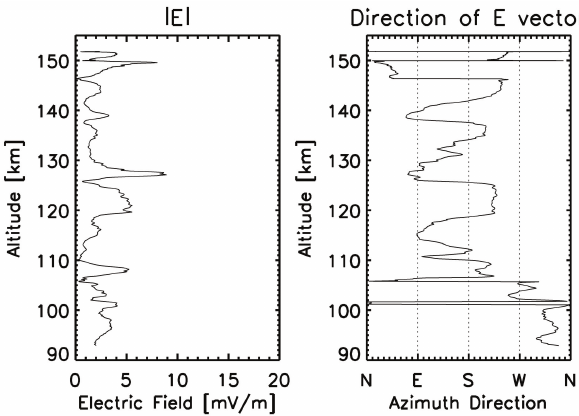
Fig. 6. Height profiles of electric field intensity (left panel) and its direction (right panel) from the electric field detector (EFD) of the S-310-31 rocket upleg (Pfaff et al.,